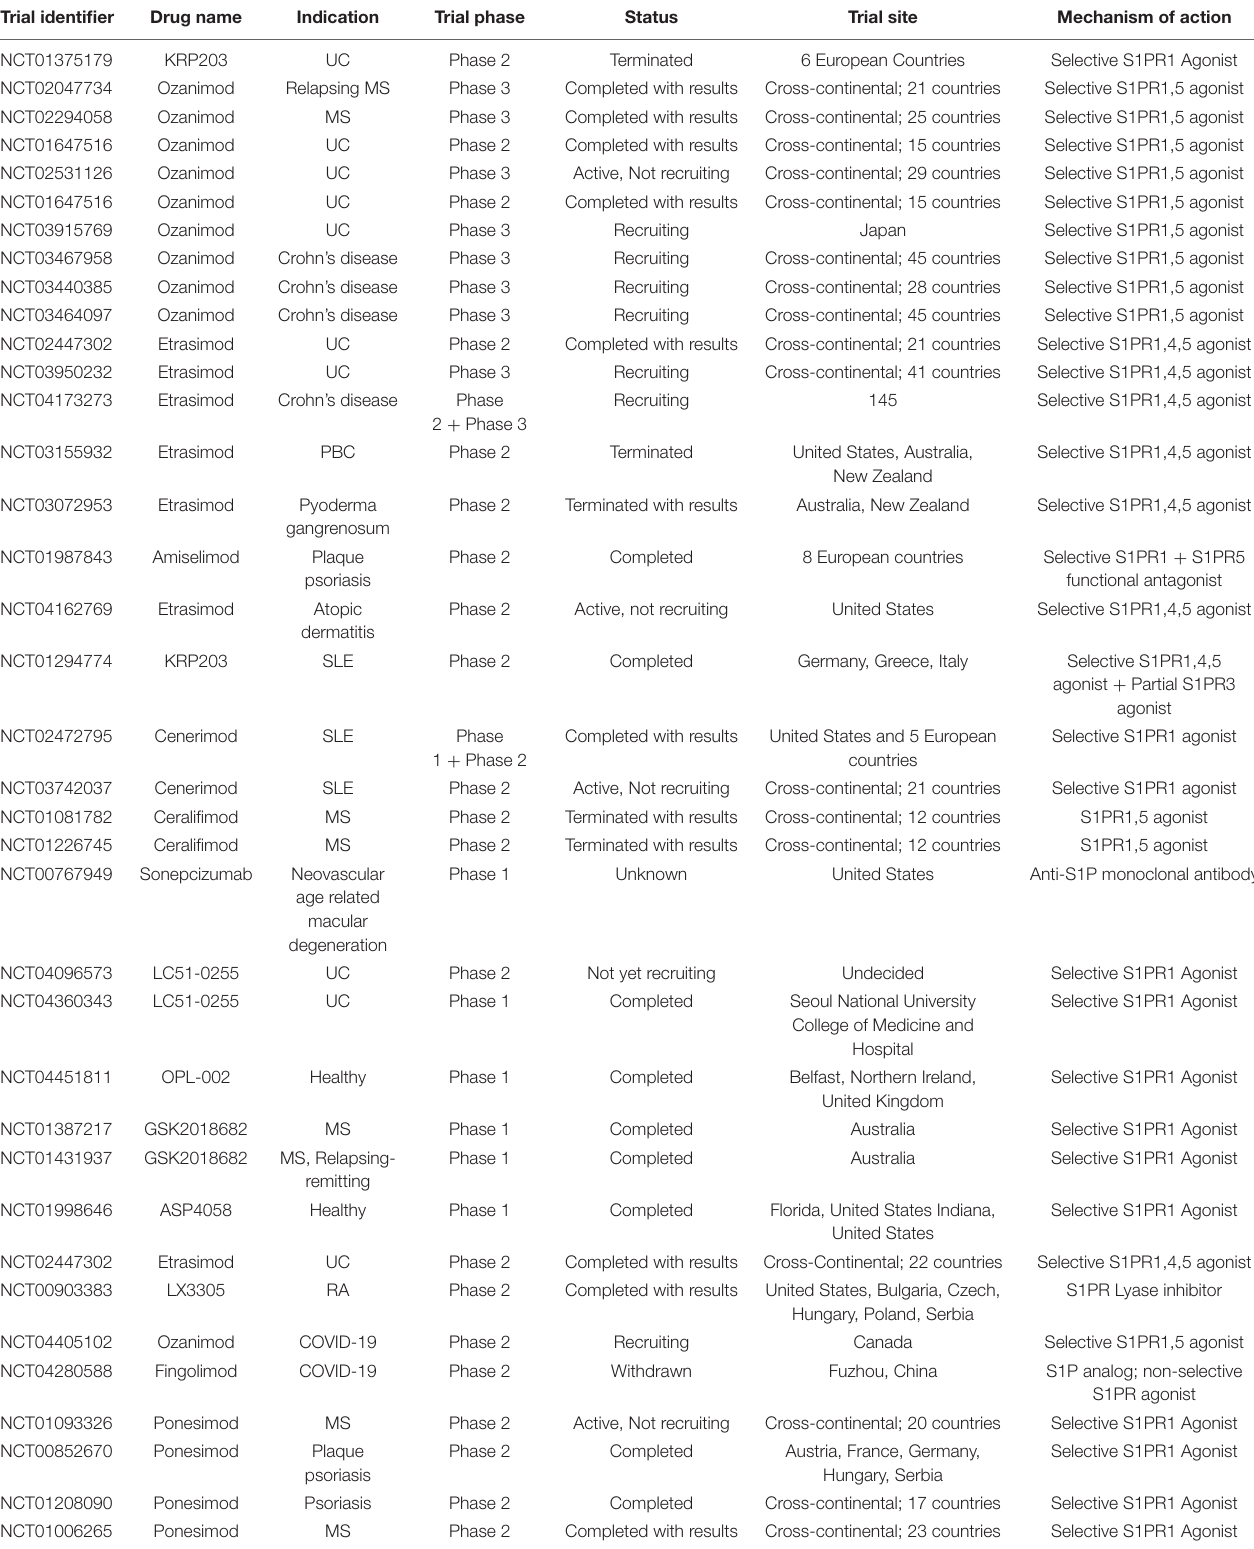
TABLE 1 | Listing of all clinical trials involving S1P modulators in any phase and with any